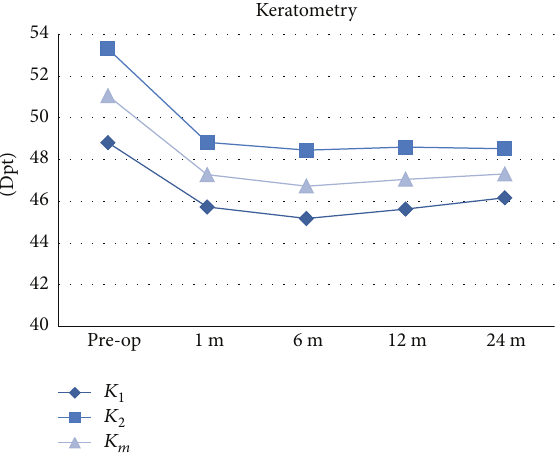
Figure 3: Keratometric changes after MyoRing implantation and CXL. D: diopters; 𝐾 1 : corneal dioptric power in the flattest meridian for the 3 mm central zone; 𝐾 2 : corneal dioptric power in the steepest meridian for the 3 mm central zone; 𝐾 𝑚 : mean corneal power in the 3 mm central zone.